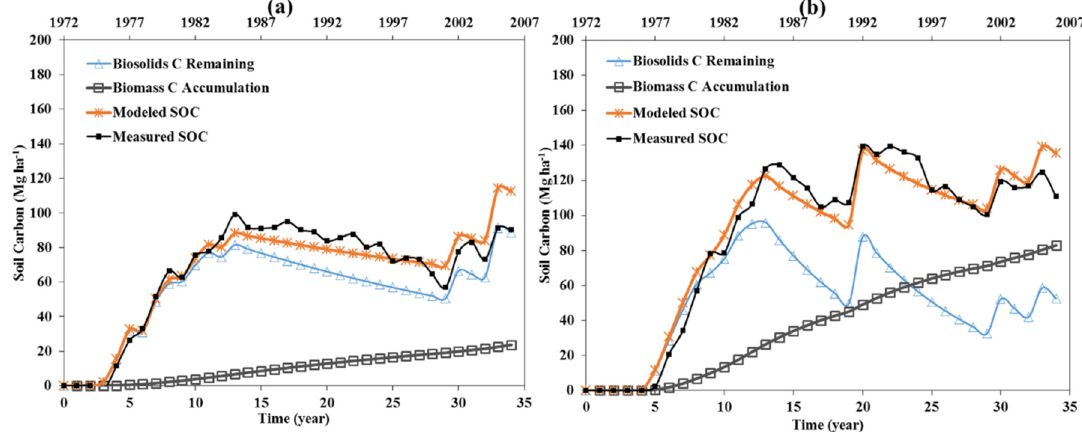
Figure 1. Example of the variation in biosolids remaining, measured and modeled soil organic carbon (SOC); ( a ) field 32 and ( b ) field 47.